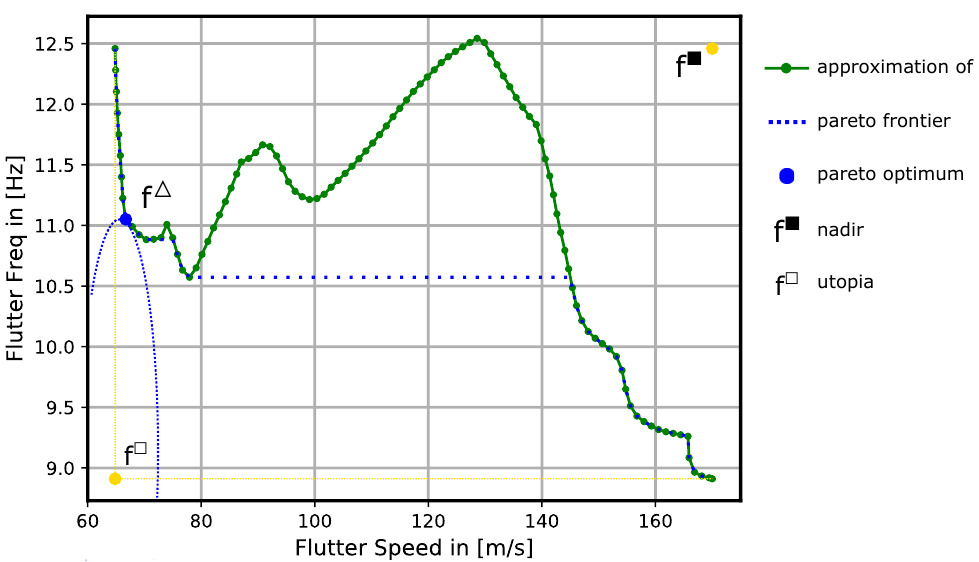
Figure 9. Reconstructed Pareto frontier of the multi-objective design optimization. Table 4. Flutter results of the Pareto optimal